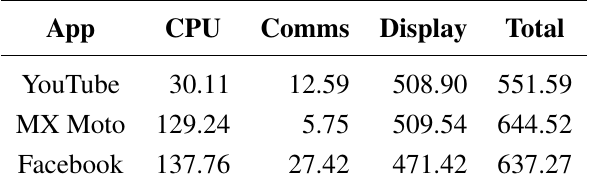
Table 2. Consumption (in Joules) of three popular apps during a time span of 10 min. App CPU Comms